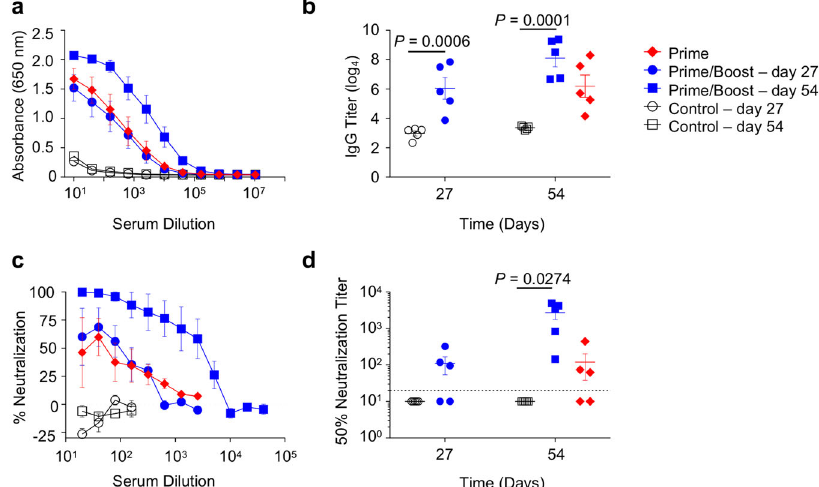
Fig. 3 MVA-VLP-SUDV vaccine elicits SUDV-speci fi c binding and neutralizing antibodies. Guinea pigs were vaccinated according the indicated regimens. Sera collected on days 27 and 54 were assessed for their ability to bind to SUDV GP ( a, b ) and neutralize SUDV Gulu ( c, d ). Mean values ± SEM. N = 5 animals per group. P values between prime/boost and control groups determined by 2-way ANOVA repeated measures followed by Bonferroni